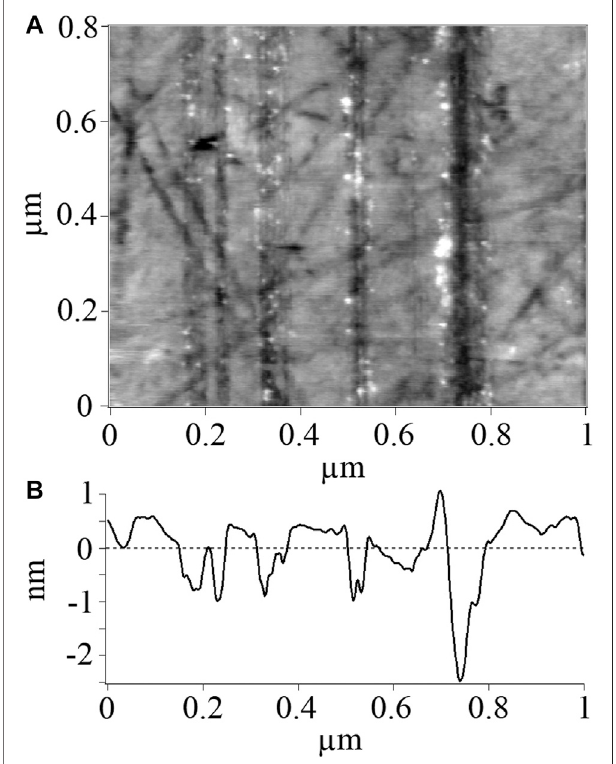
FIGURE 4 | (A) A detail of the topography of a wear scar with a single scratch (category 1) with a Z -scale of ± 4 nm. (B) An average of all line pro fi les is